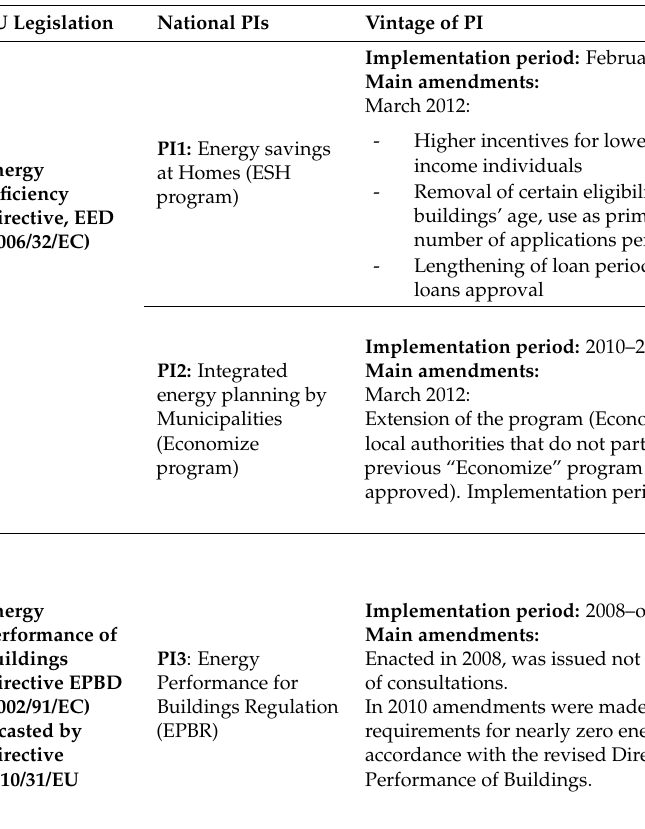
Table 1. Summary of national PIs, their objectives and observed effects in accordance to EU Directives (partly adapted by